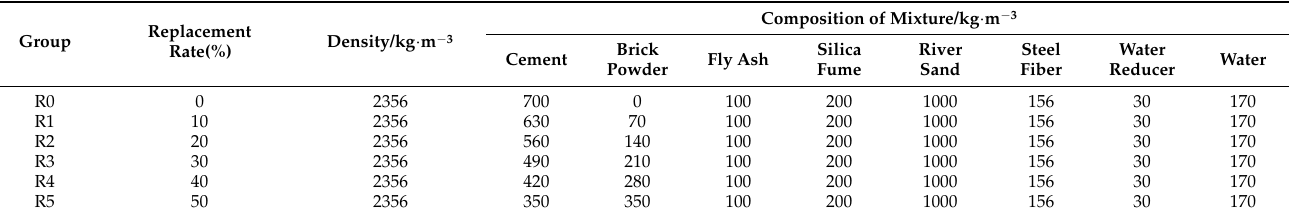
Table 3. Mix proportion of recycled brick powder UHPC (kg/m 3 ).